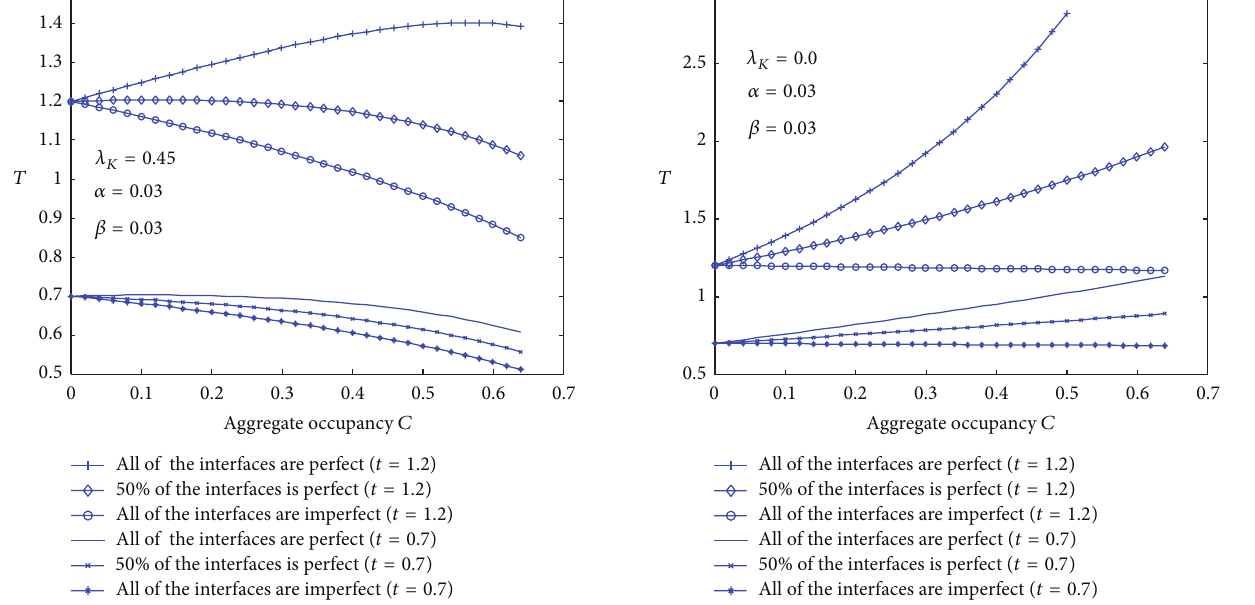
Figure 2: The change curve of the macroscopic inner friction coefficient with aggregate occupancy for different matrix inner friction coefficient ( 𝜆 𝐾 = 0.45 ).